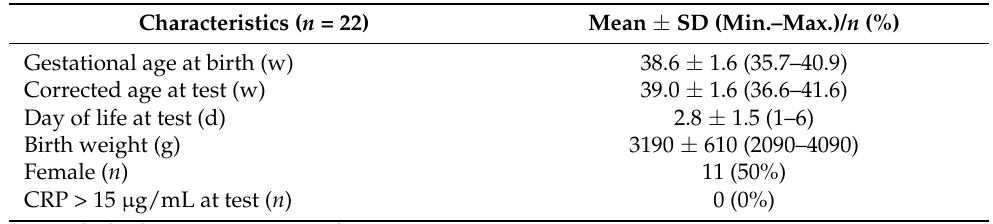
Table 3. Characteristics of healthy neonates without corresponding serum CRP concentrations shown as mean ± SD (minimum (min.)–maximum (max.)) or numbers ( n ) and percentage